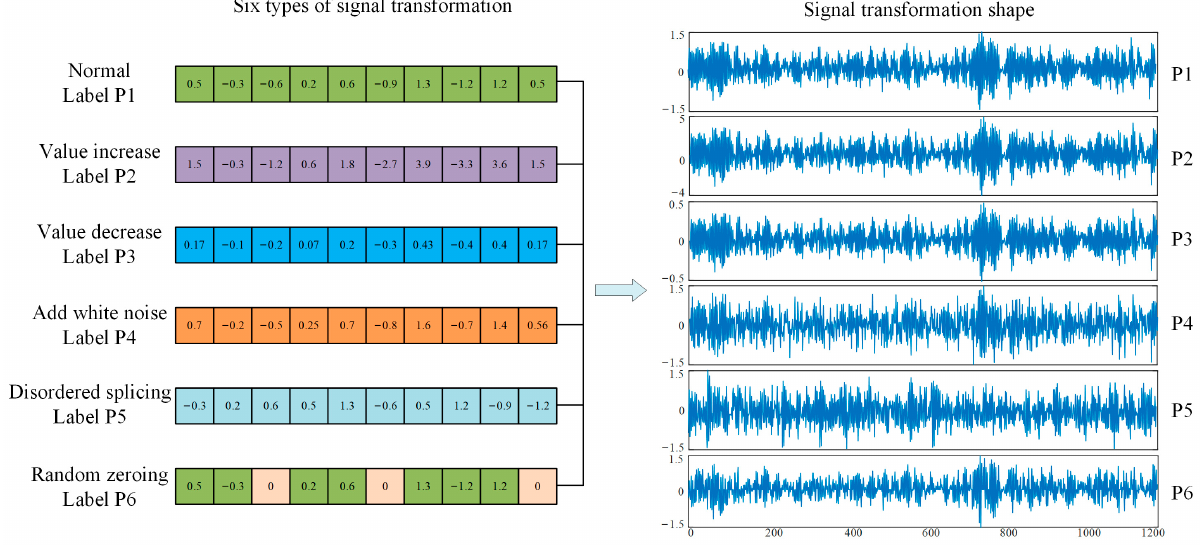
Figure 2. Shapes of six signal transformation methods.